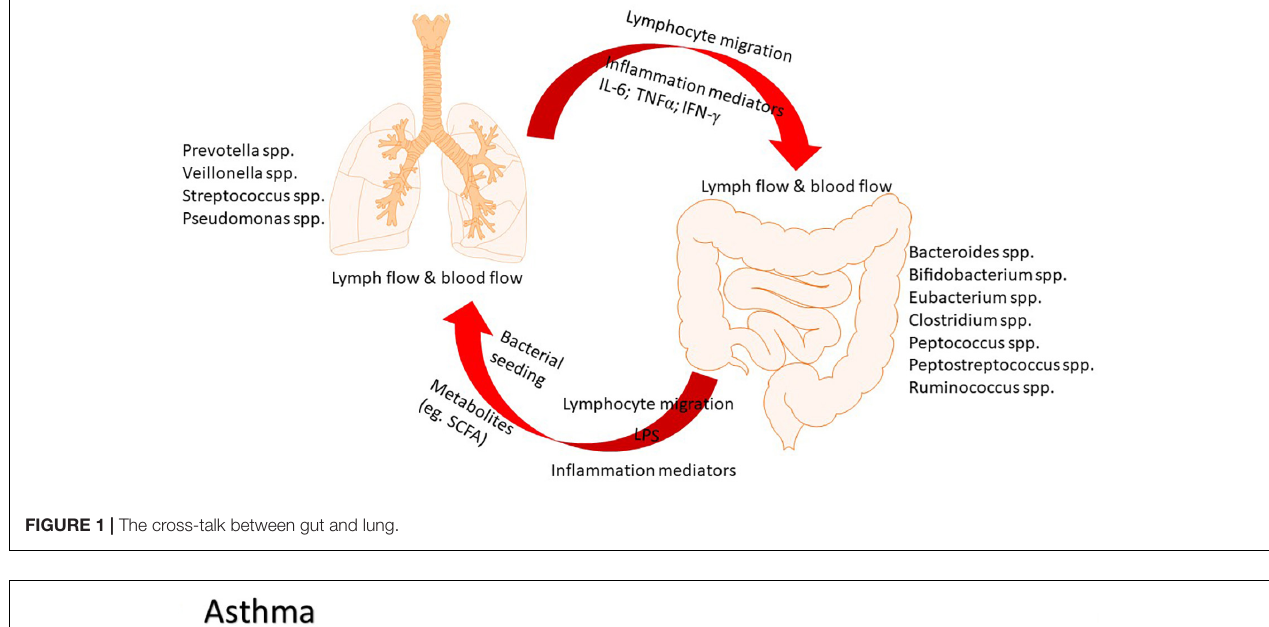
FIGURE 1 | The cross-talk between gut and lung.